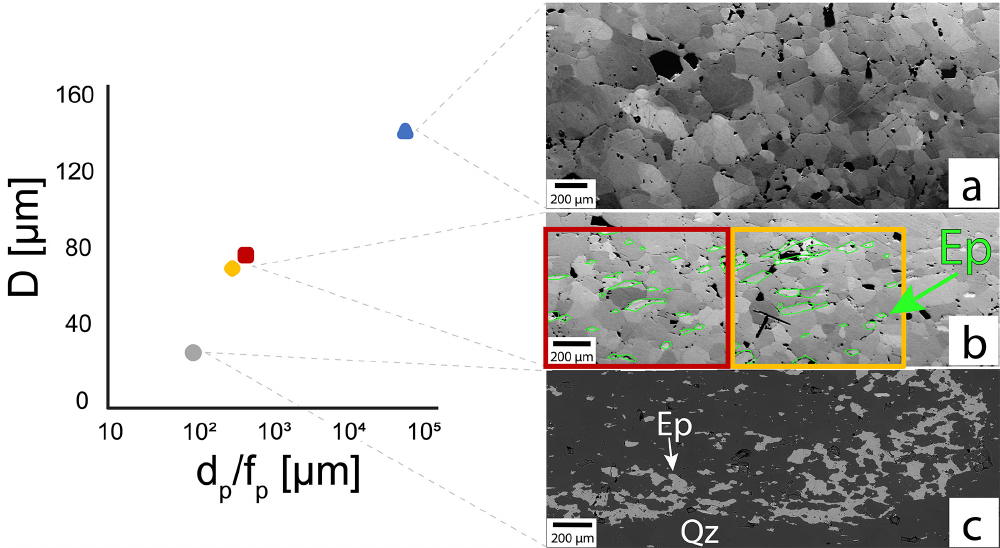
Figure 7. Correlation between quartz grain size ( D ) and Zener parameter (ratio between size and abundance of the second phase, here epidote, p ; d p/ f p ) of epidote as the second phase determined in the FSE and BSE images of the microstructures in the microfold of layers 2–3. The green lines in the central BSE image contour epidote grains. Ep: epidote; Qz: quartz. Panels (a) , (b) , and (c) correspond, respectively, to Fig. 4c, a, and